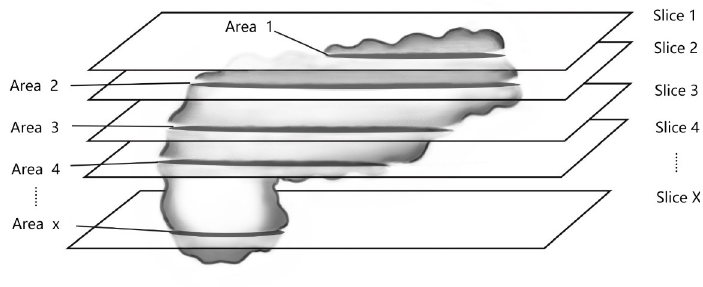
Fig 3. Calculation of pancreatic fat content by measuring all pancreatic layers